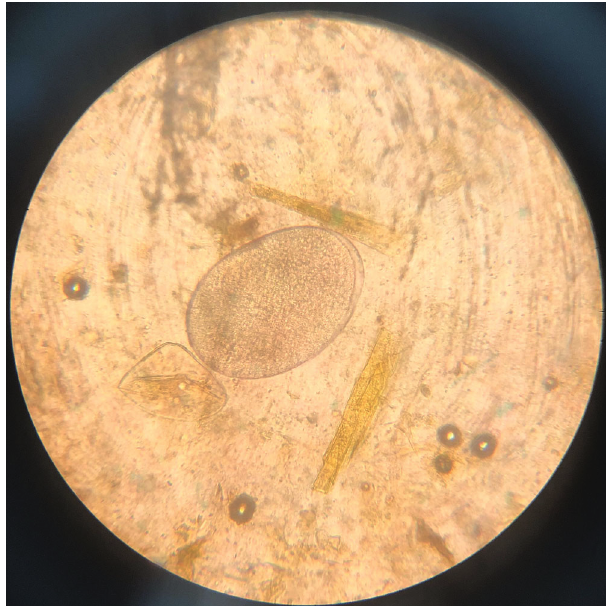
Figure 5: Strongyloides : egg of parasite. Ellipsoid, 40 – 85 μ m in length, with a thin wall containing the fi rst-stage larva.